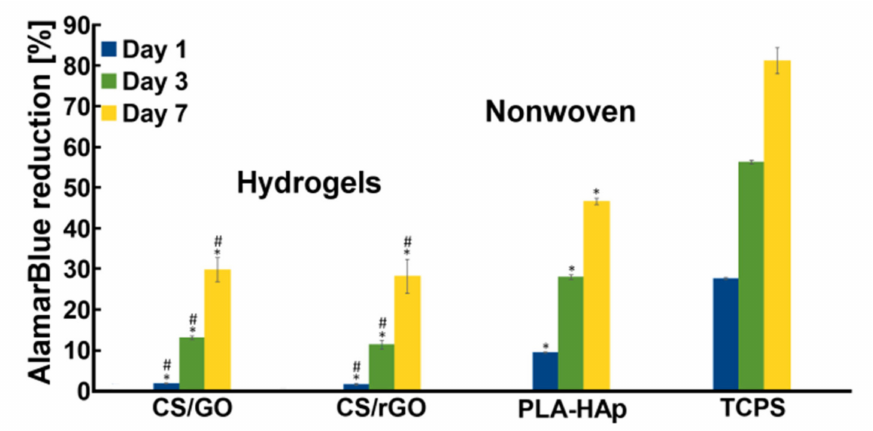
Figure 11. Cell metabolic activity measured by AlamarBlue ® test—after 24 h, 3 and 7 days. Results: mean ± s.e.m., n = 6, statistical significance: at p < 0.05 as compared to *TCPS, # nonwoven PLA /